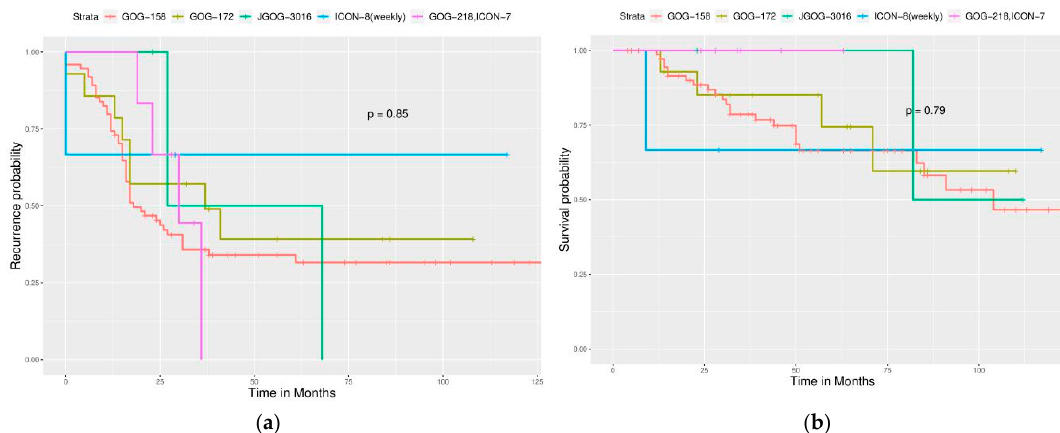
Figure 9. Survival curves by adjuvant chemotherapy regimens (Optimally debulked group) ( a ) PFS, p = 0.85, ( b ) OS, p = 0.79.